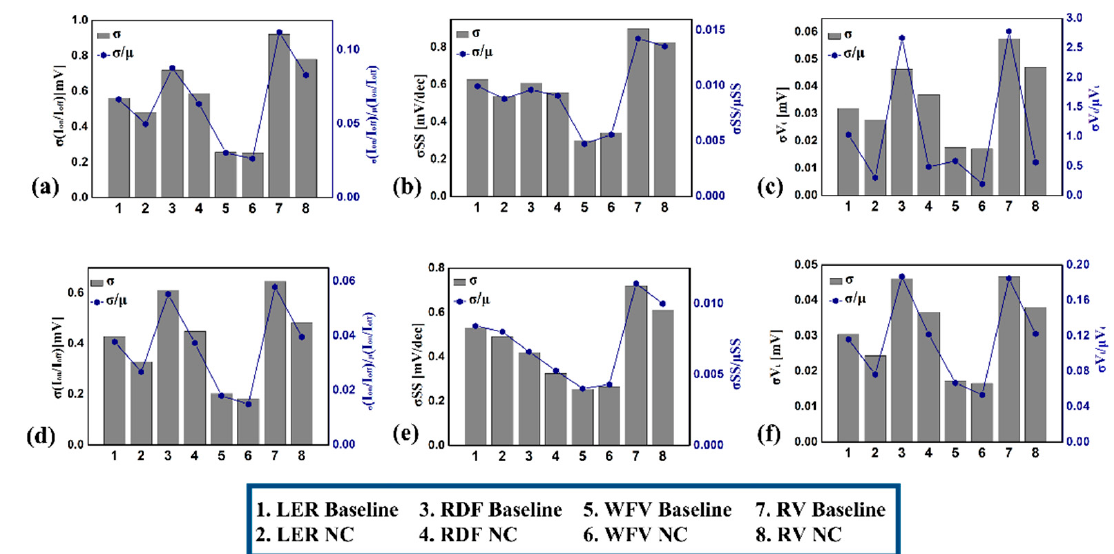
Figure 8. ( a ) On/off ratio variation [ σ (I on /I off )] and [ σ (I on /I off )/µ(I on /I off )] comparison, ( b ) SS variation [ σ (SS)] and [ σ (SS)/µ(SS)] comparison and ( c ) V t variations [ σ (V t )] and [ σ (V t )] comparison between n-type JL-NWFET and n-type NC-JL-NWFET in saturation mode. ( d ) On/off ratio variation [ σ (I on /I off )] and [ σ (I on /I off )/µ(I on /I off )] comparison, ( e ) SS variation [ σ (SS)] and [ σ (SS)/µ(SS)] comparisons and ( f ) V t variations [ σ (V t )] and [ σ (V t )] comparison between p-type JL-NWFET and p-type NC-JL-NWFET in saturation mode.